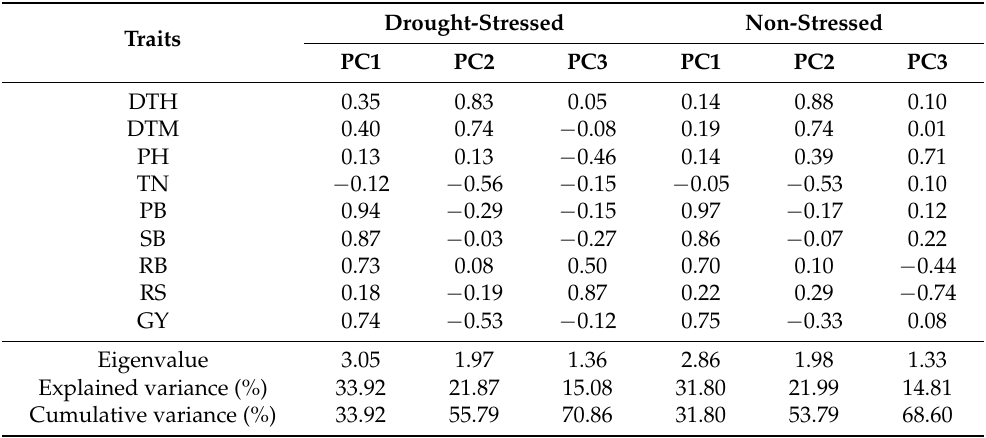
Table 4. Principal component scores and variance of traits measured on 97 wheat genotypes assessed under drought-stress and non-stress conditions.